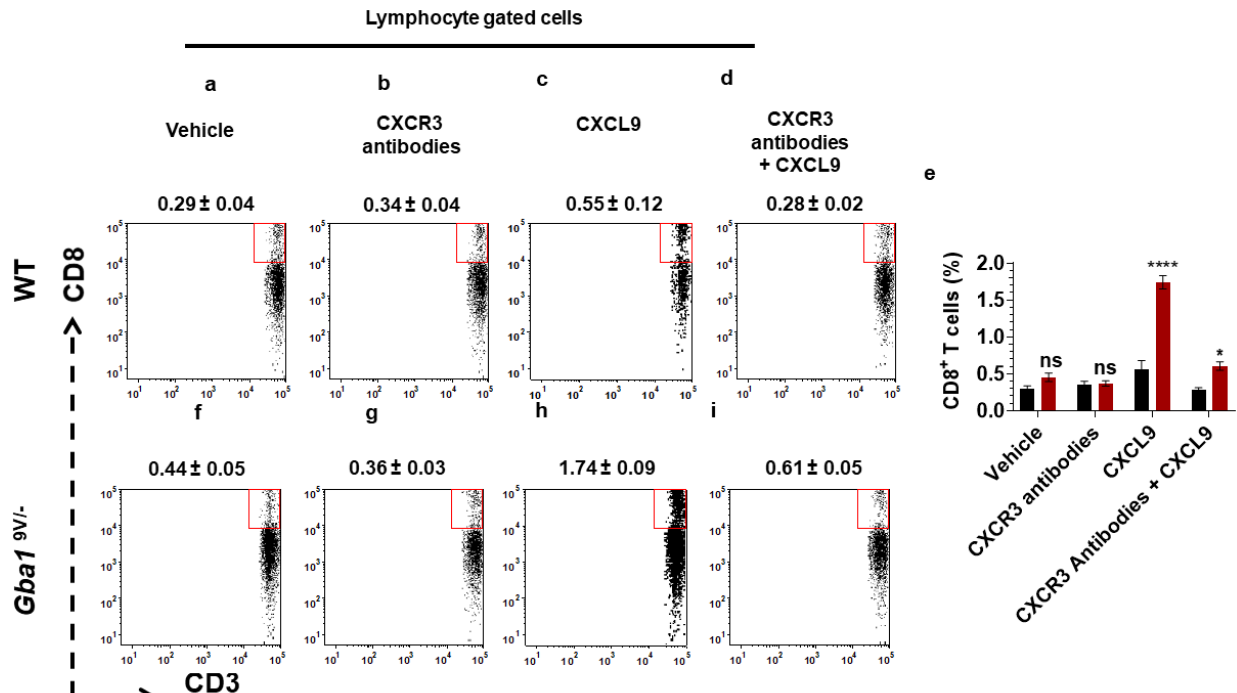
Figure 7. In vivo blocking of CXCR3 alters the CXCL9-mediated CD8 + T cells chemotaxis in Gba1 9V/ − mice. WT and Gba1 9V/- mice were injected with intraperitoneal administration of CXCL9 and its vehicle as described in the method. In additional experiments, these mice were injected with intravenous injection of mouse anti-CXCR3 antibodies prior to intraperitoneal injection of CXCL9 or vehicle and the peritoneal cells were collected and analyzed by FACS. The dot plots and the corresponding bar diagrams represent the percentage of migrated CD3 + CD8 + T cells in WT ( a – e ) and Gba1 9V/- mice ( e – i ). WT (black columns), Gba1 9V/- (maroon columns), and the values shown are the mean ± SD. and group comparison were performed with ANOVA. Three independent experiments were conducted (ns, not significant; * p < 0.05; **** p < 0.0001).